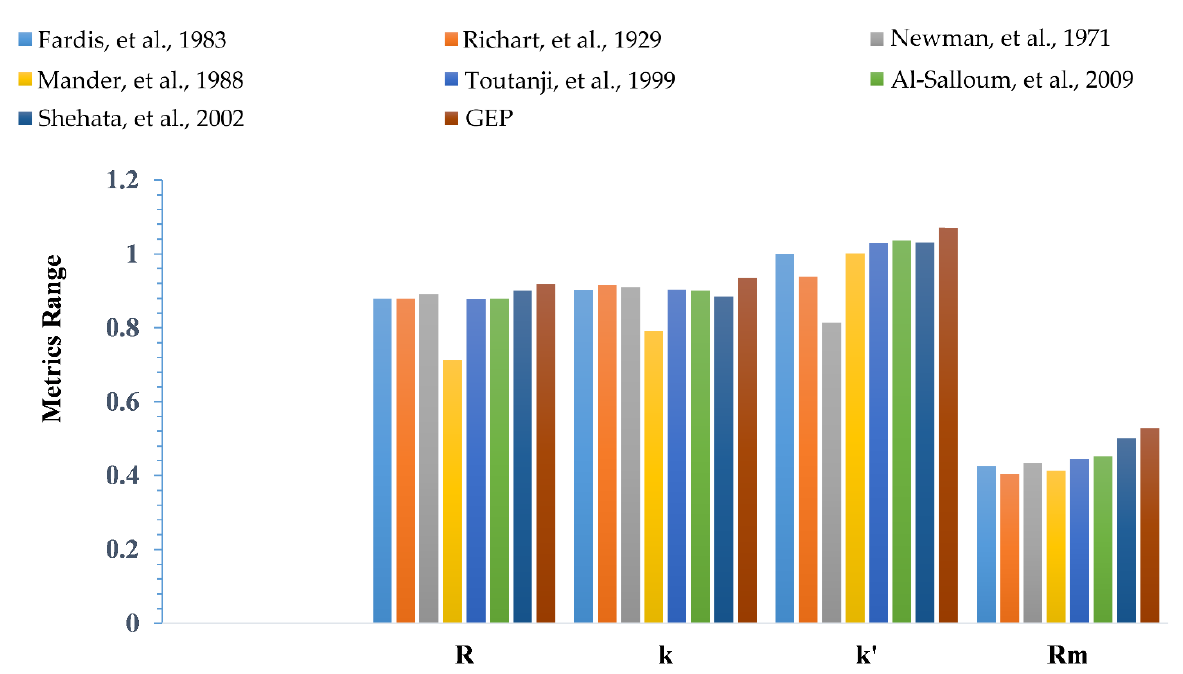
Figure 6. External validation based on the evaluation of proposed and exist-ing models [12,14 – 16,79,84,86].